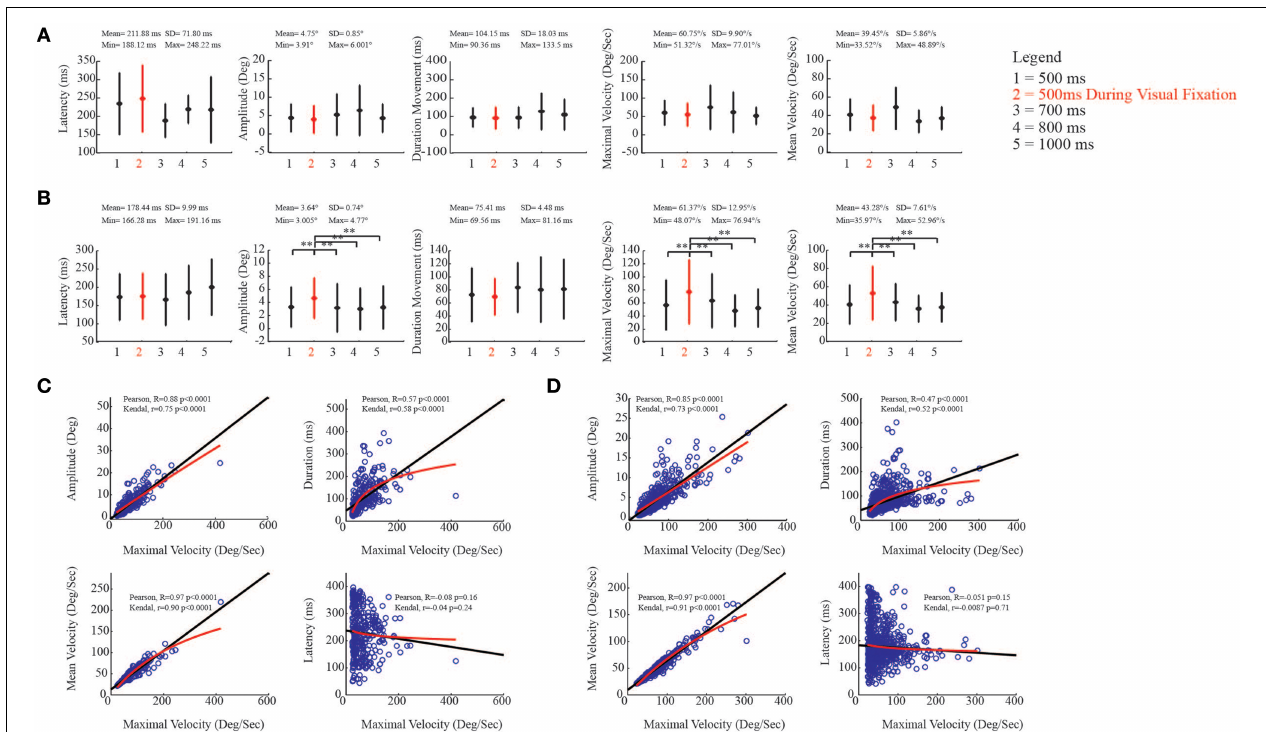
FIGURE 8 | Kinematic study of the evoked ear movements. (A) Plots put in relation ear kinematic parameters of the core region with the duration of stimulation (numbers on x-axis), during visual fixation task (red), and spontaneous conditions (black). The descriptive statistic shows data which are means ± SEM of 386 determinations; ∗∗ p < 0 . 05. Min corresponds to the average minimum value within the 5 conditions. Max corresponds to the average maximum value within the 5 conditions. (B) Plots put in relation ear kinematic parameters of the belt region with the